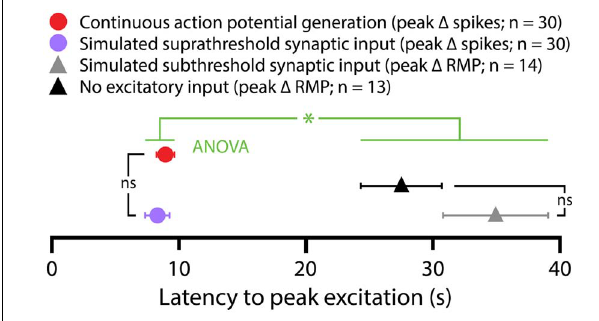
FIGURE 3 | Latencies of serotonergic responses in COM-excited L5PNs. Plot of the latencies to peak excitatory responses (defined as peak increases in action potential frequencies or peak depolarization from RMPs) for COM-excited neurons experiencing 5-HT application during suprathreshold DC current injection (red symbol), suprathreshold (purple symbol) or subthreshold (gray symbol) simulated synaptic currents, or in the absence of any extrinsic excitatory drive (black symbol). Serotonergic responses occurring in the presence of suprathreshold drive had shorter latencies to peak than did responses at RMPs or during subthreshold simulated synaptic input ( p < 0. 05, One-way